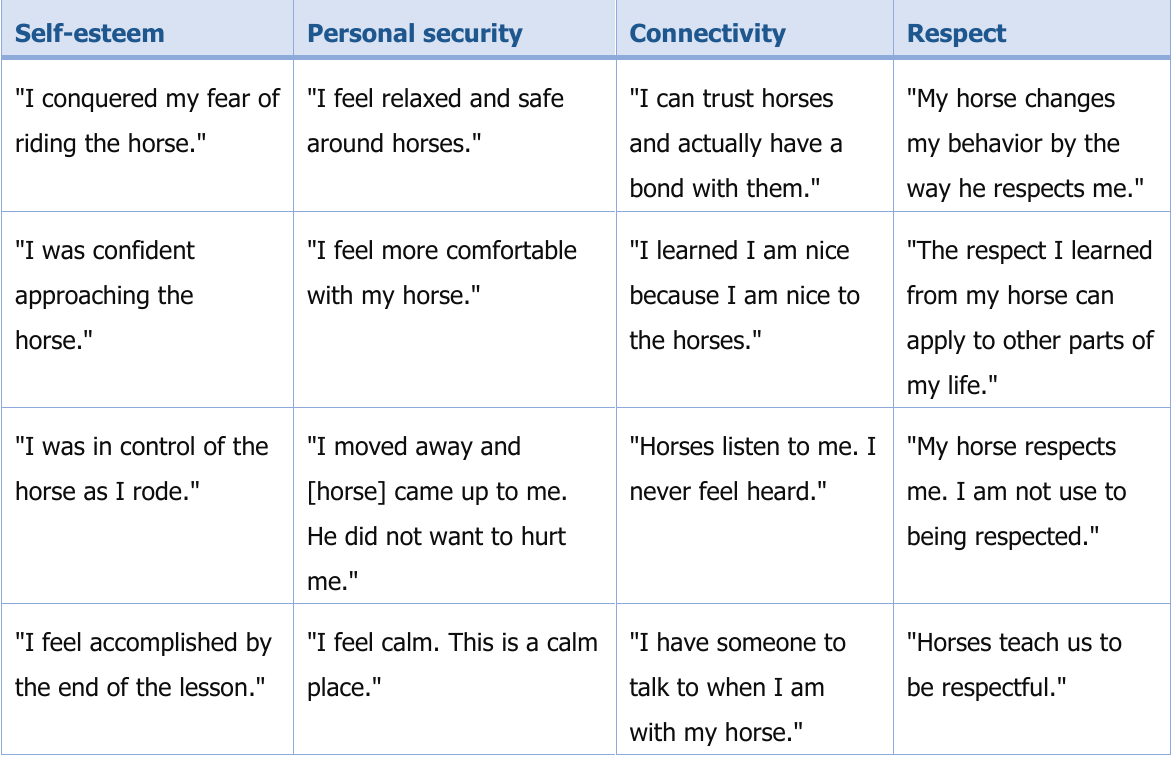
Table 4. At-Risk Youth Example Responses From Equine Assisted Learning Debriefing Interviews Organized by Emotional Safety Category